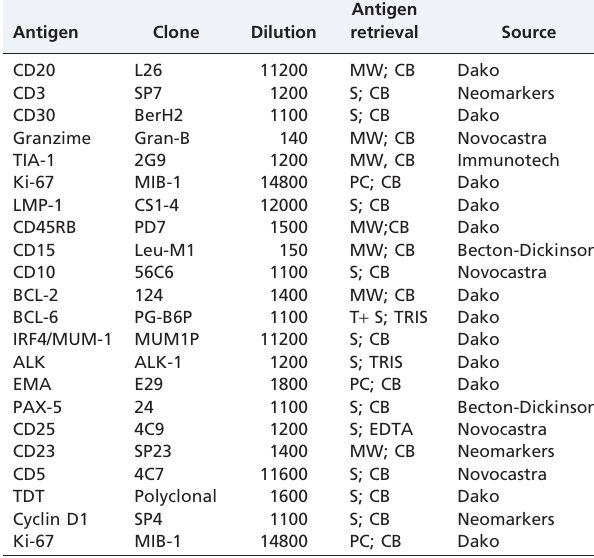
Table 1 - Primary antibodies used